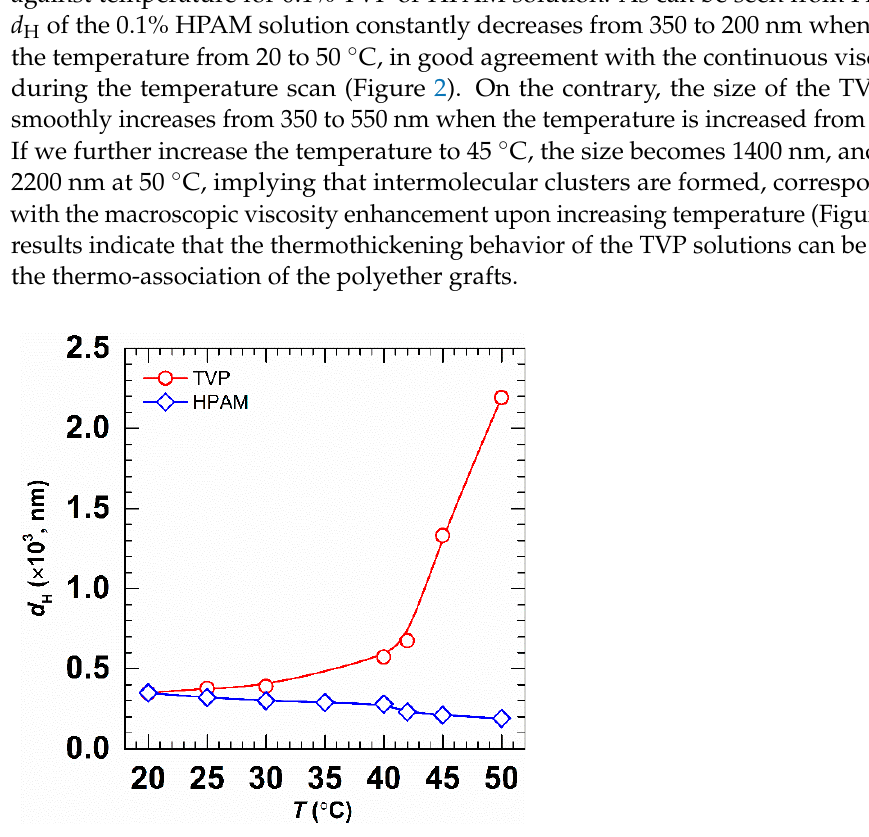
Figure 3. The hydrodynamic size ( d H ) of both TVP and HPAM plotted against temperature for 0.1% polymer solution. Solvent: synthetic produced fluid, 4500 mg/LTDS containing 65 mg/L Ca 2+ and Mg 2+ .